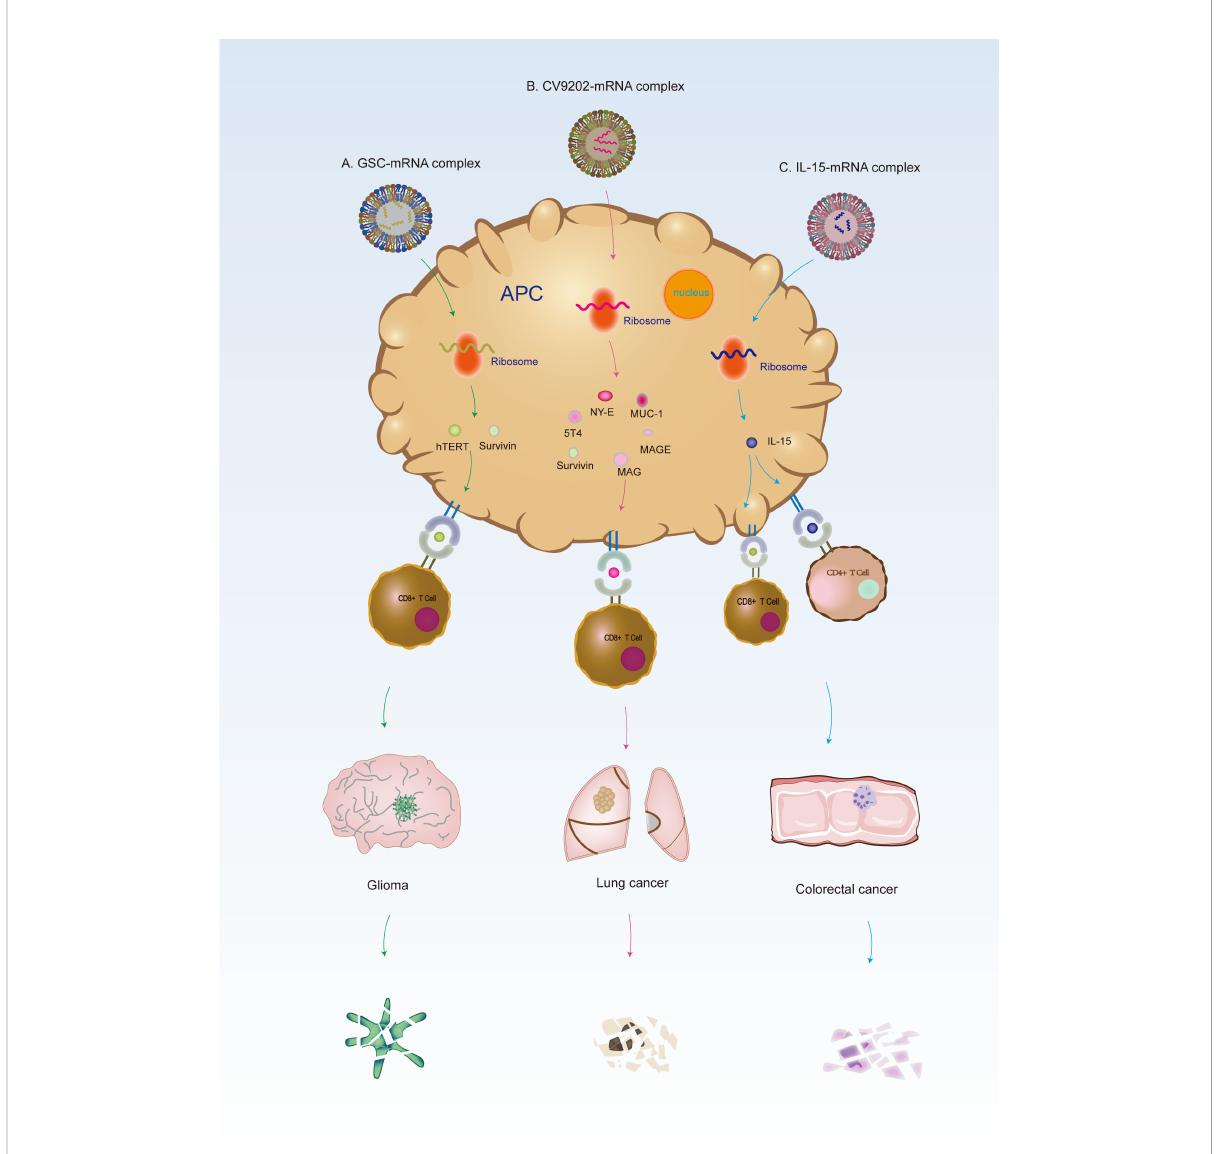
FIGURE 3 Mechanism of mRNA vaccines against lung cancer, CRC and glioma. (A) Glioma stem cells (GSC): Autologous dendritic cells transfected with autologous GSC-mRNA are utilized to induce an immune response against the GSC of patients. GSC-mRNA can translate hTERT and survivin to induce the immune response. (B) Lung cancer: CV9202 is a cancer immunotherapy with sequence-optimized mRNAs encoding different cancer antigens in free and complexed form with the CLPP; this facilitates antigen expression and activation of the immune system, essentially conferring self-adjuvant activity and subsequently inducing an adaptive cellular and humoral immune response. (C) CRC: After the CLPP/mRNA complex enters the body, CLPP can deliver the IL-15-mRNA to antigen-presenting cells (APCs), and then APCs will translate IL-15 protein and release it, causing cellular immune response and promoting the cell death of